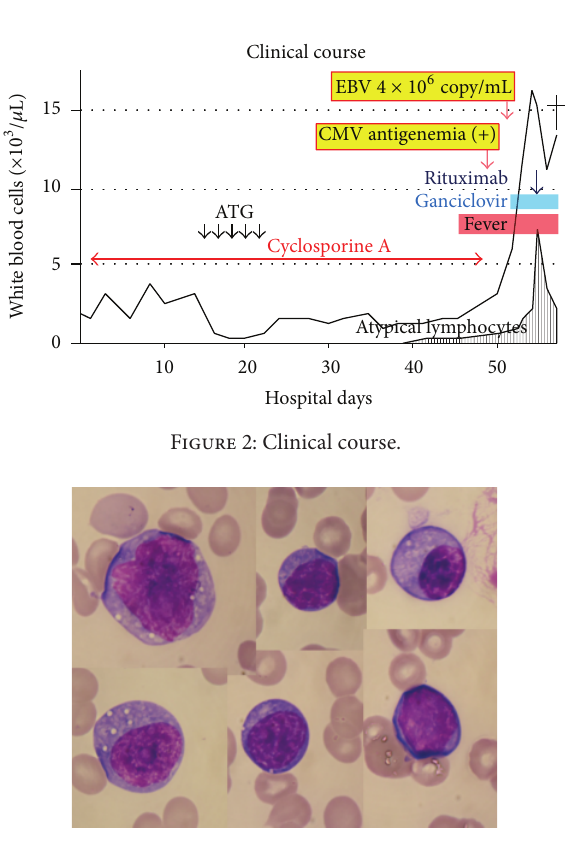
Figure 3: Atypical lymphocytes in the peripheral